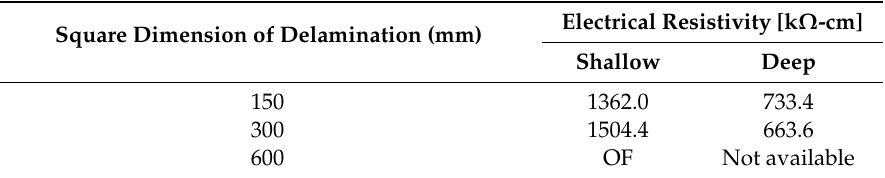
Table 5. Electrical resistivity of concrete slab at di ff erent sizes of delamination